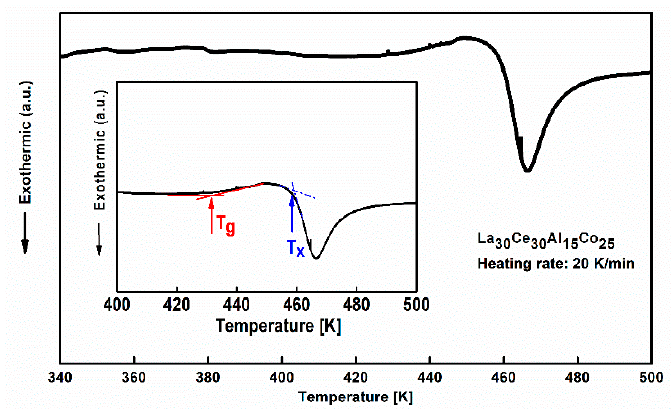
Figure 2. DSC curve of La 30 Ce 30 Al 15 Co 25 metallic glass (heating rate: 20 K/min). Inset is the definition of the glass transition temperature T g and the onset temperature of crystallization T x .